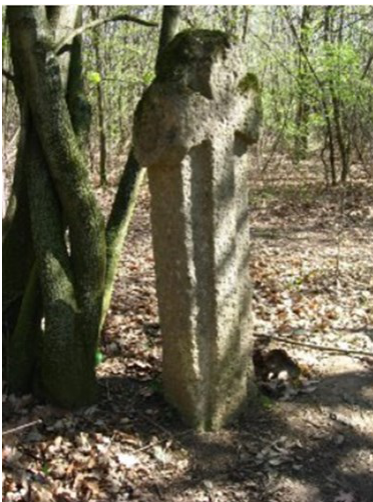
Figure 2. Boundary stone of the 15 th century in Lower Austria “Oara”-stone, from Latin ora = hem or border. (Paul